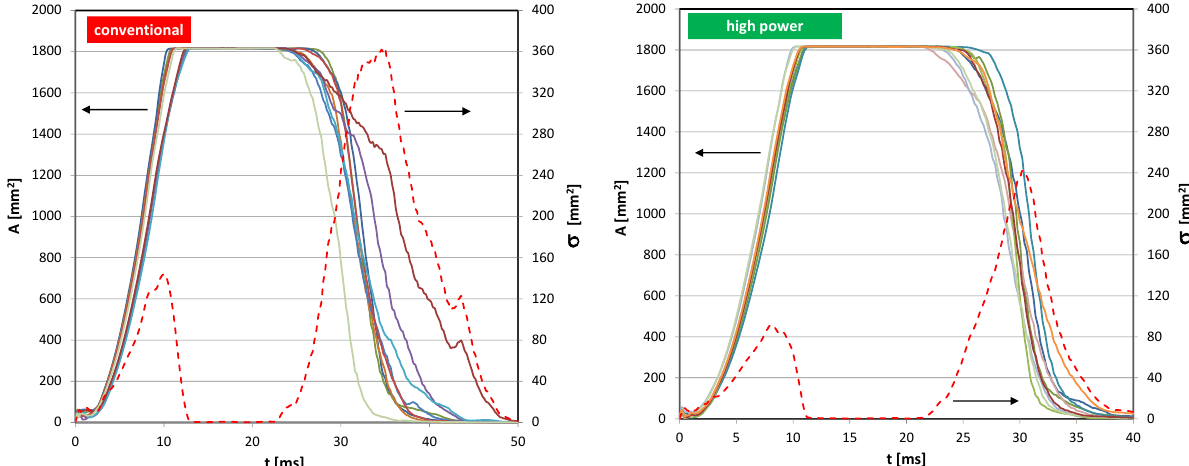
Fig. 7. Flame surface area as a function of time (solid line) and its standard deviation (dashed line); on the left – conventional ignition, on the right – high- power ignition